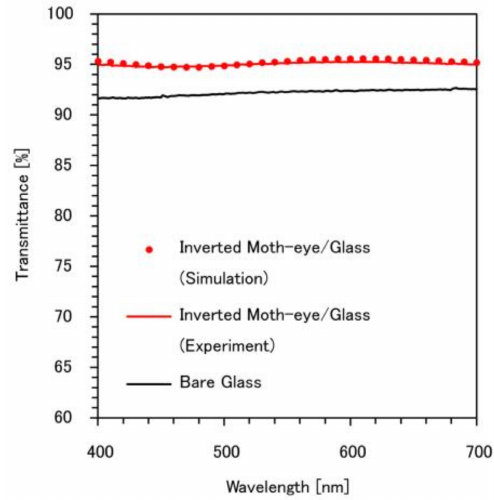
Figure 7. Transmission spectrum of a glass substrate bonded to PDMS having an inverted moth-eye structure. The spectrum for glass and the simulated spectrum are shown for comparison purposes.